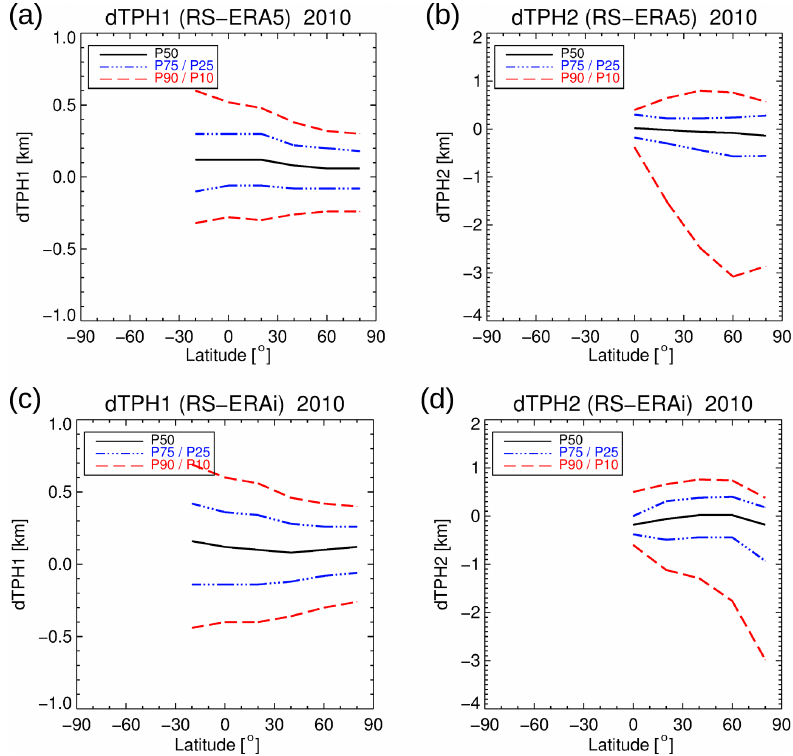
Figure 18. Zonal percentiles P 10 , P 25 , P 50 (median), P 75 , and P 90 of the tropopause height differences between HVRRD and ERA5 for the first tropopause (dTPH 1 ) in panel (a) and the second tropopause (dTPH 2 ) in panel (b) , as well as for ERA-Interim in panel (c) and (d) , respectively. Note the change and asymmetry in the y range between first and second tropopause differences. Statistics apply for the year